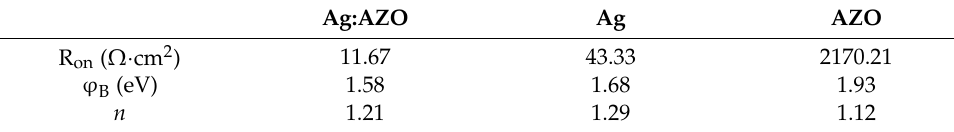
Figure 8. Photodetector I–V curves using 20 nm-thick electrodes. Table 6. Electrical parameters of the photodetector for each